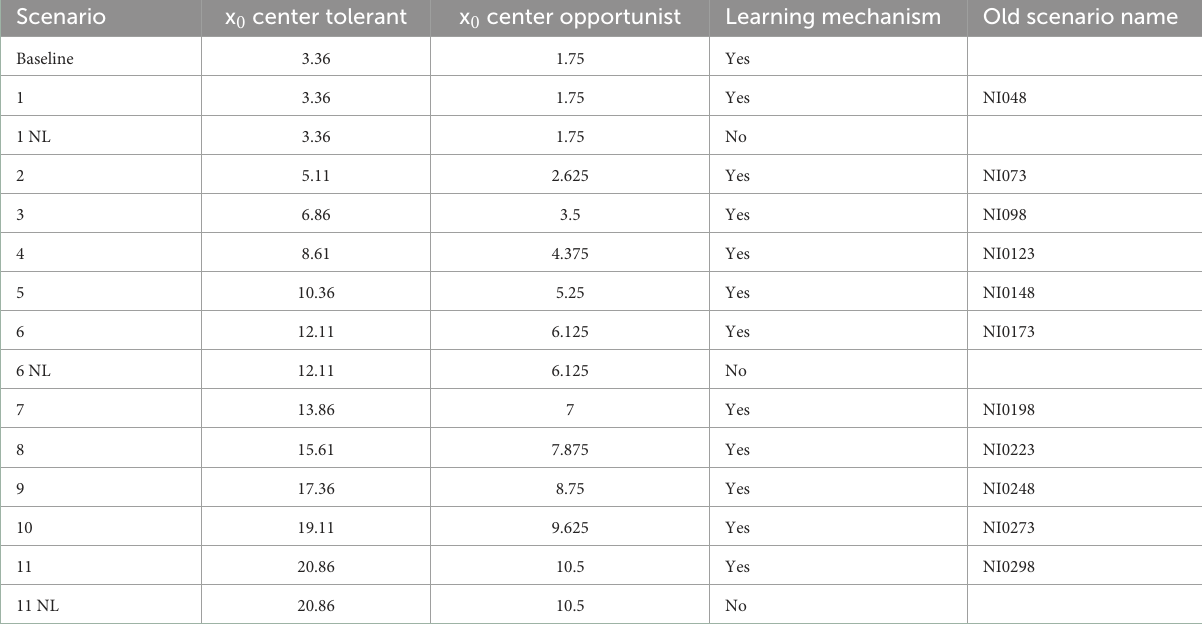
TABLE 3 Values of x 0 used for the experiment